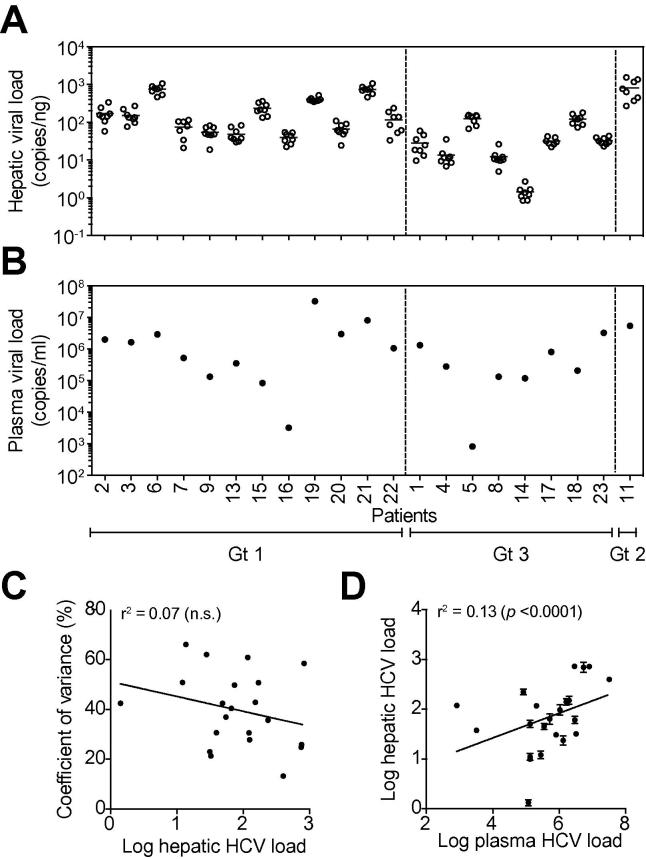
HCV RNA levels in the liver and plasma at the time of transplant. The levels of HCV RNA in the hepatic RNA (A) samples described in Fig. 1 along with the plasma-derived RNA (B) were quantified by RT-PCR. Data are presented for each biopsy showing the mean expression HCV RNA/ng total RNA (open circles) and from matched plasma samples showing HCV RNA/ml plasma (closed circles). The mean HCV RNA level ± SD is indicated for each liver. To assess whether the hepatic viral RNA burden (mean HCV RNA of all 8 liver samples) dictates variation across the liver (coefficient of variance – HCV RNA variance/mean HCV RNA) (C) or plasma RNA levels (D) we measured the correlation between these parameters.